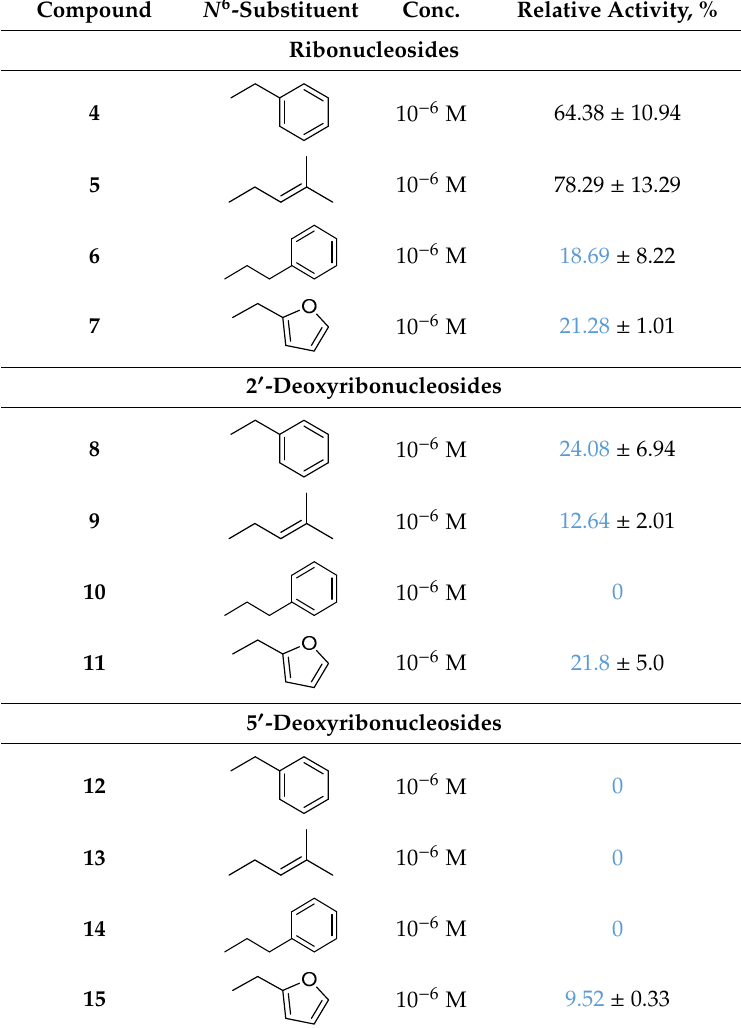
Table 1. Cytokinin activity (in %) of nucleoside derivatives (at two concentrations) in bioassay based on Arabidopsis thaliana double mutants. BA activity was taken as 100% 1 .